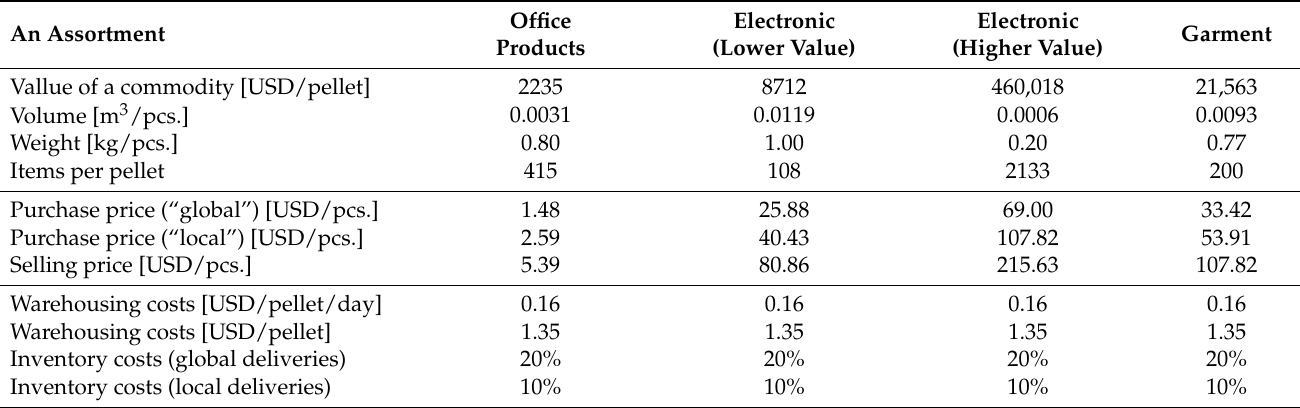
Table 1. Assumptions for calculations.